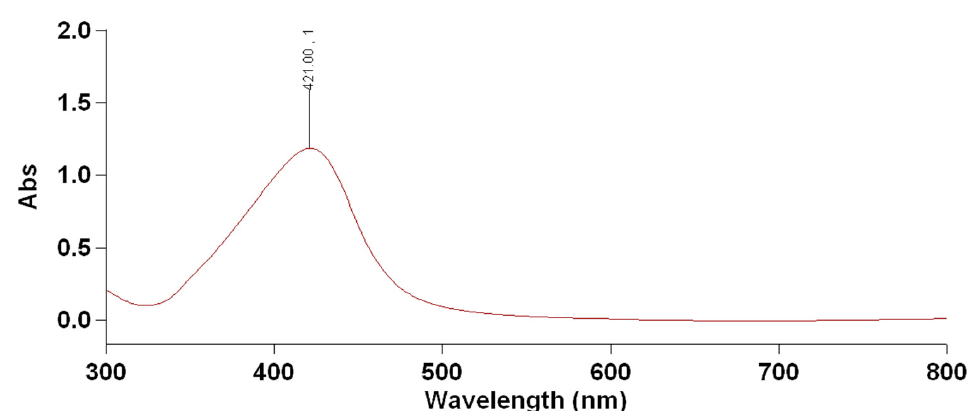
Figure 2. UV-Visible spectrum of silver nanoparticles produced by Streptomyces aizuneusis ATCC 14921.